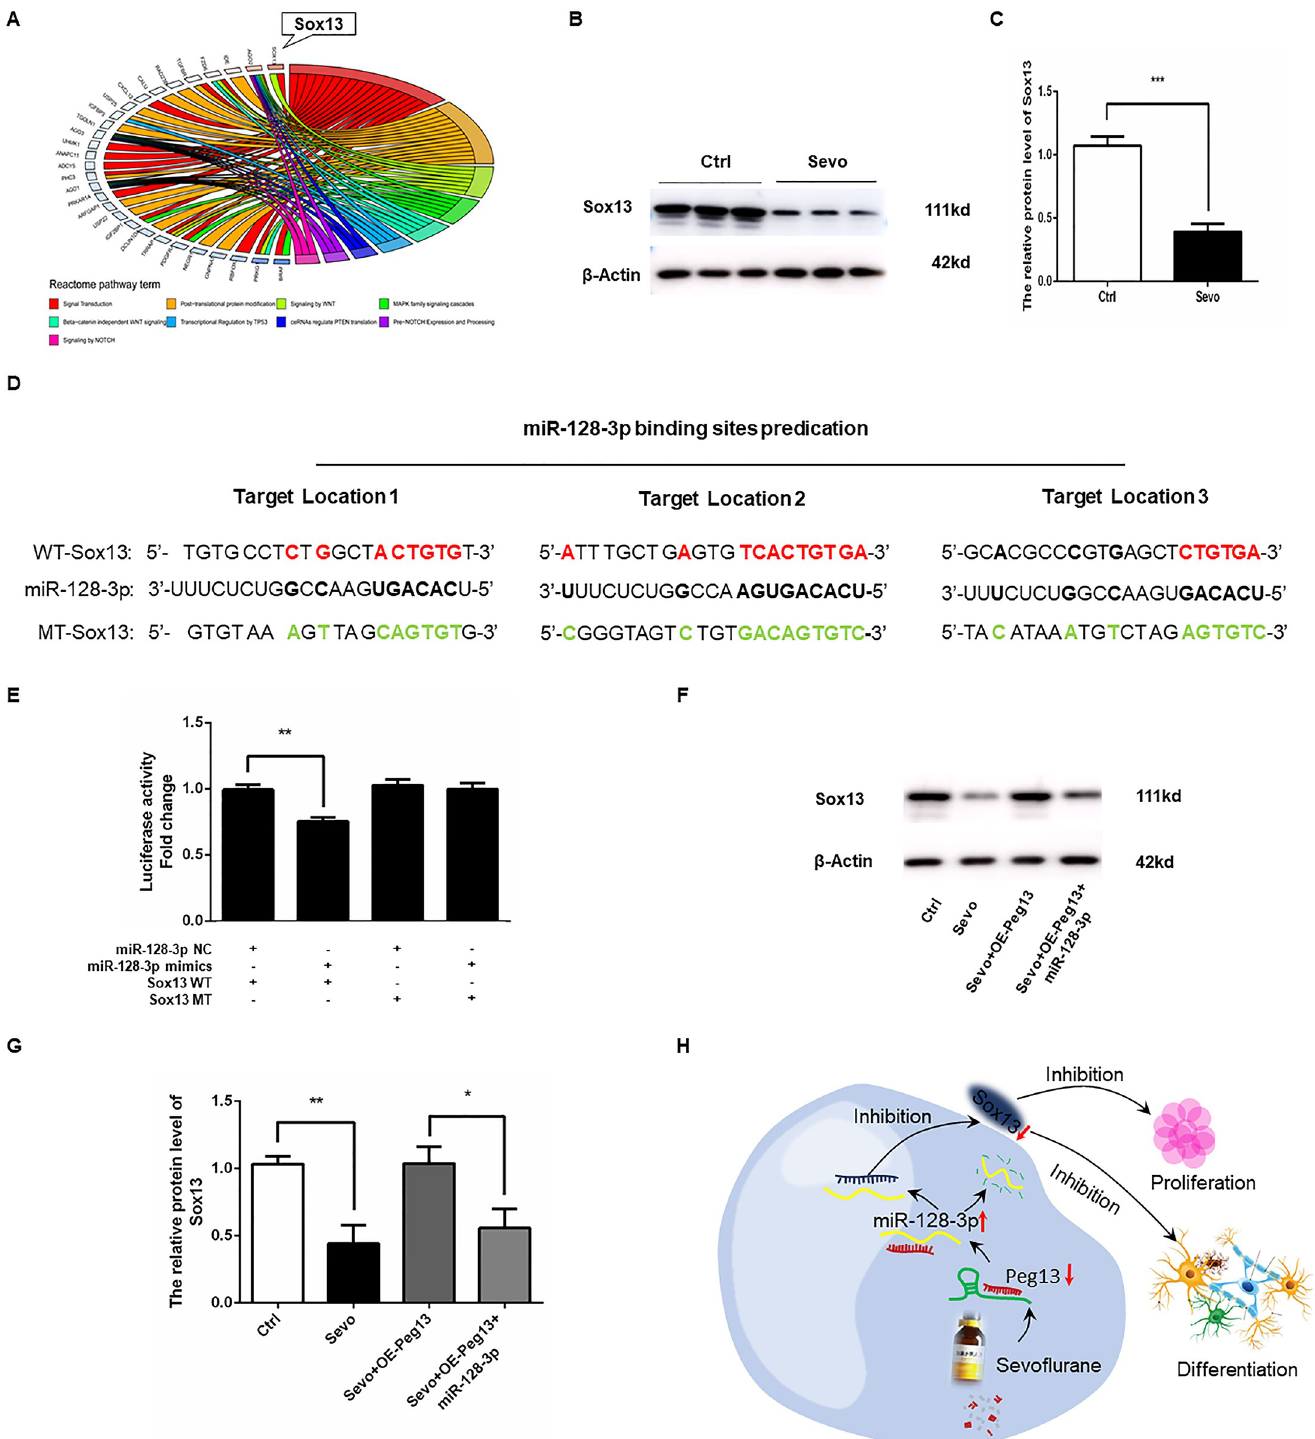
Fig 6. Peg13 over-expression rescues the sevoflurane neurotoxicity by sponging miR-128-3p to preserve Sox13 expression in NSCs. A. Pathway analysis indicated that the Sox13-related signal pathways were involved in the sevoflurane-related neurotoxicity in NSCs. B, C. Western blotting displayed that sevoflurane exposure decreased Sox13 expression in NSCs. D. Bioinformatics predicted that miR-128-3p bound to the 3 0 UTR of Sox mRNA. E. Luciferase reporter assay indicated that miR-128-3p over-expression reduced the wild-type Sox13-regulated, but not its mutant-regulated, luciferase expression in 293T cells. F, G. Peg13 over- expression restored Sox13 expression in the sevoflurane-exposed NSCs, which was mitigated by miR-128-3p over-expression. H. A diagram illustrates the